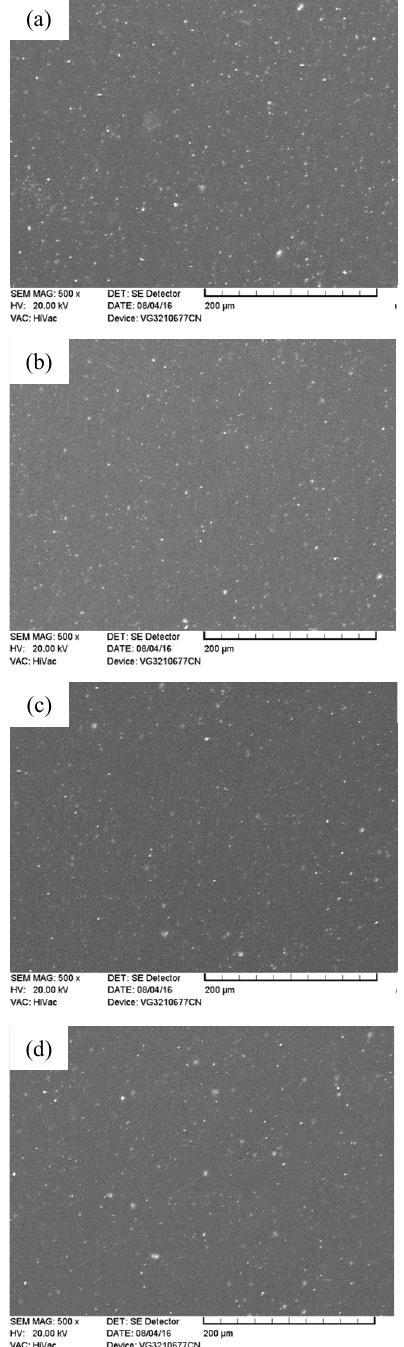
Fig. 16 Wear surface topography with the S07 steel disk with DLC film: PV = (a) 15 MPa·(m/s), (b) 20 MPa·(m/s), (c) 25 MPa·(m/s), and (d) 30